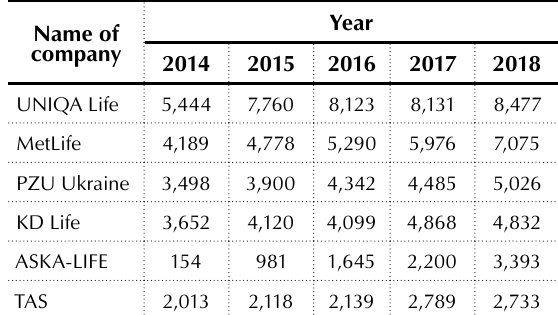
Table 1. Insurance premiums for one insured from savings life insurance, UAH